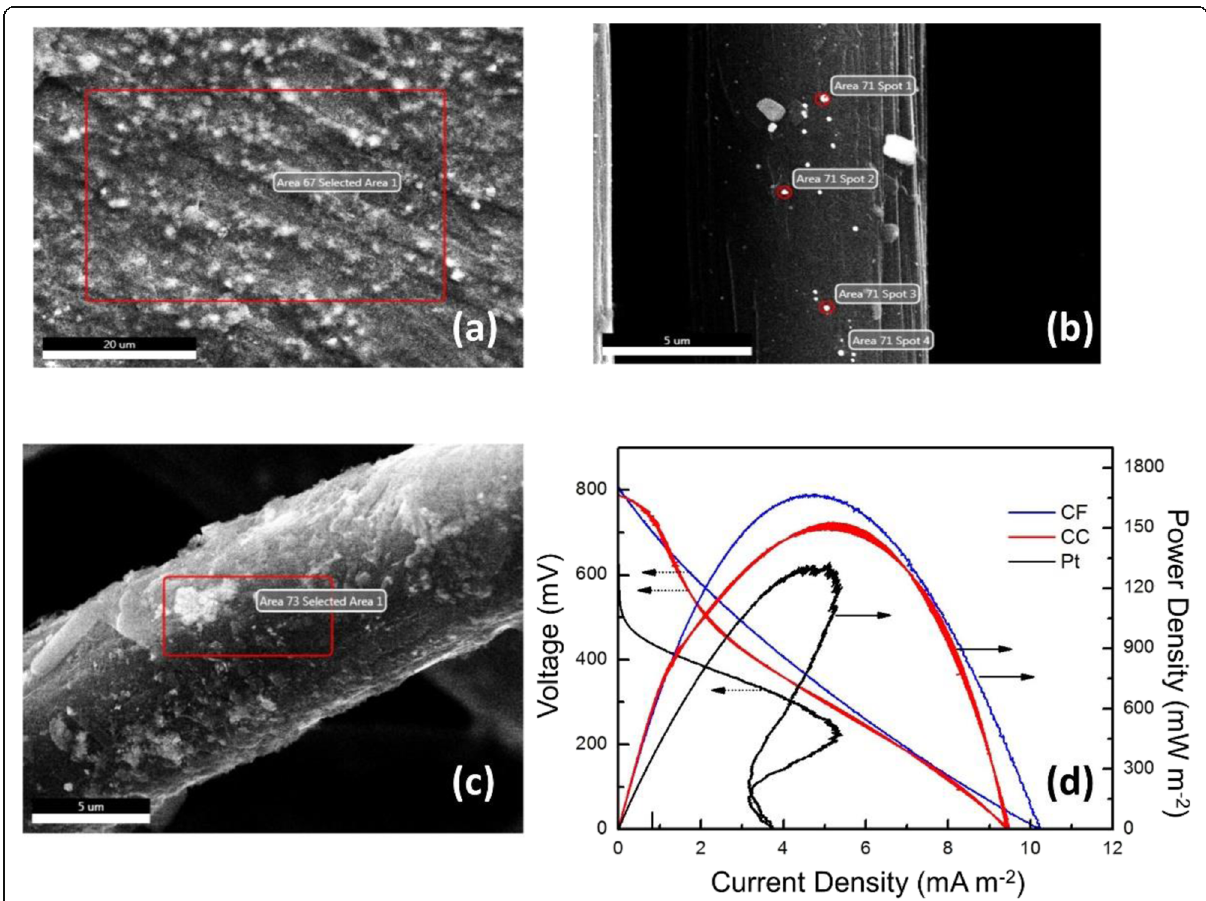
Fig. 7 SEM image of Cr and Cu adsorbed on the surface of cathode: a Pt; b CC; c CF; d Polarization